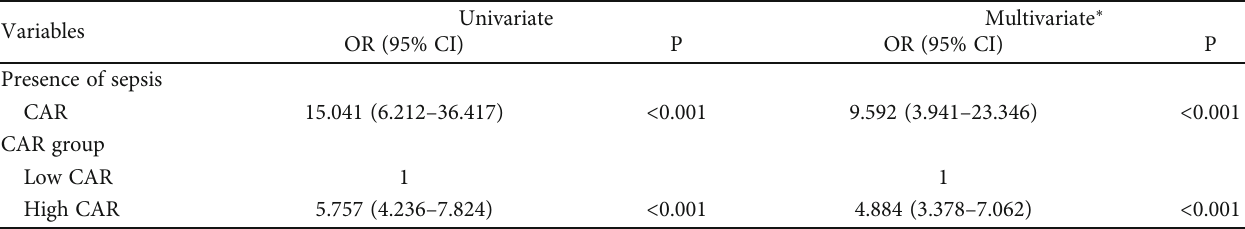
Table 4: Predictive value of CAR for sepsis in neonates with pneumonia.